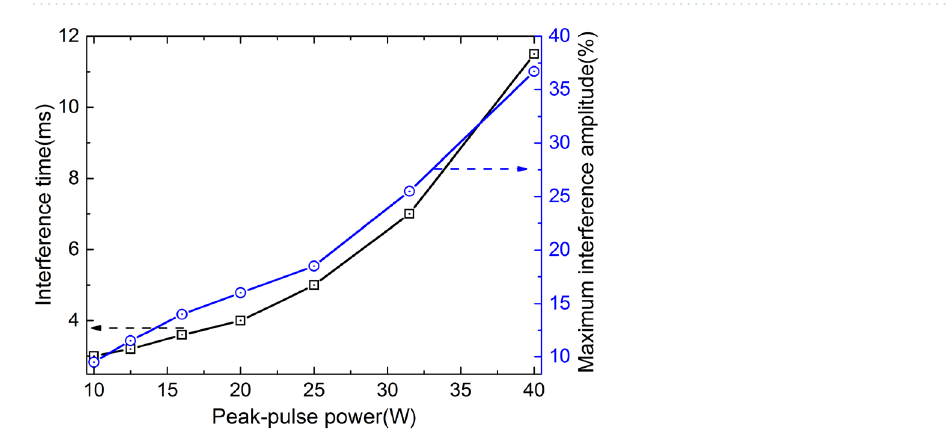
Figure 6. Relationships between the output interference time, maximum interference amplitude and the injected peak power of the microwave